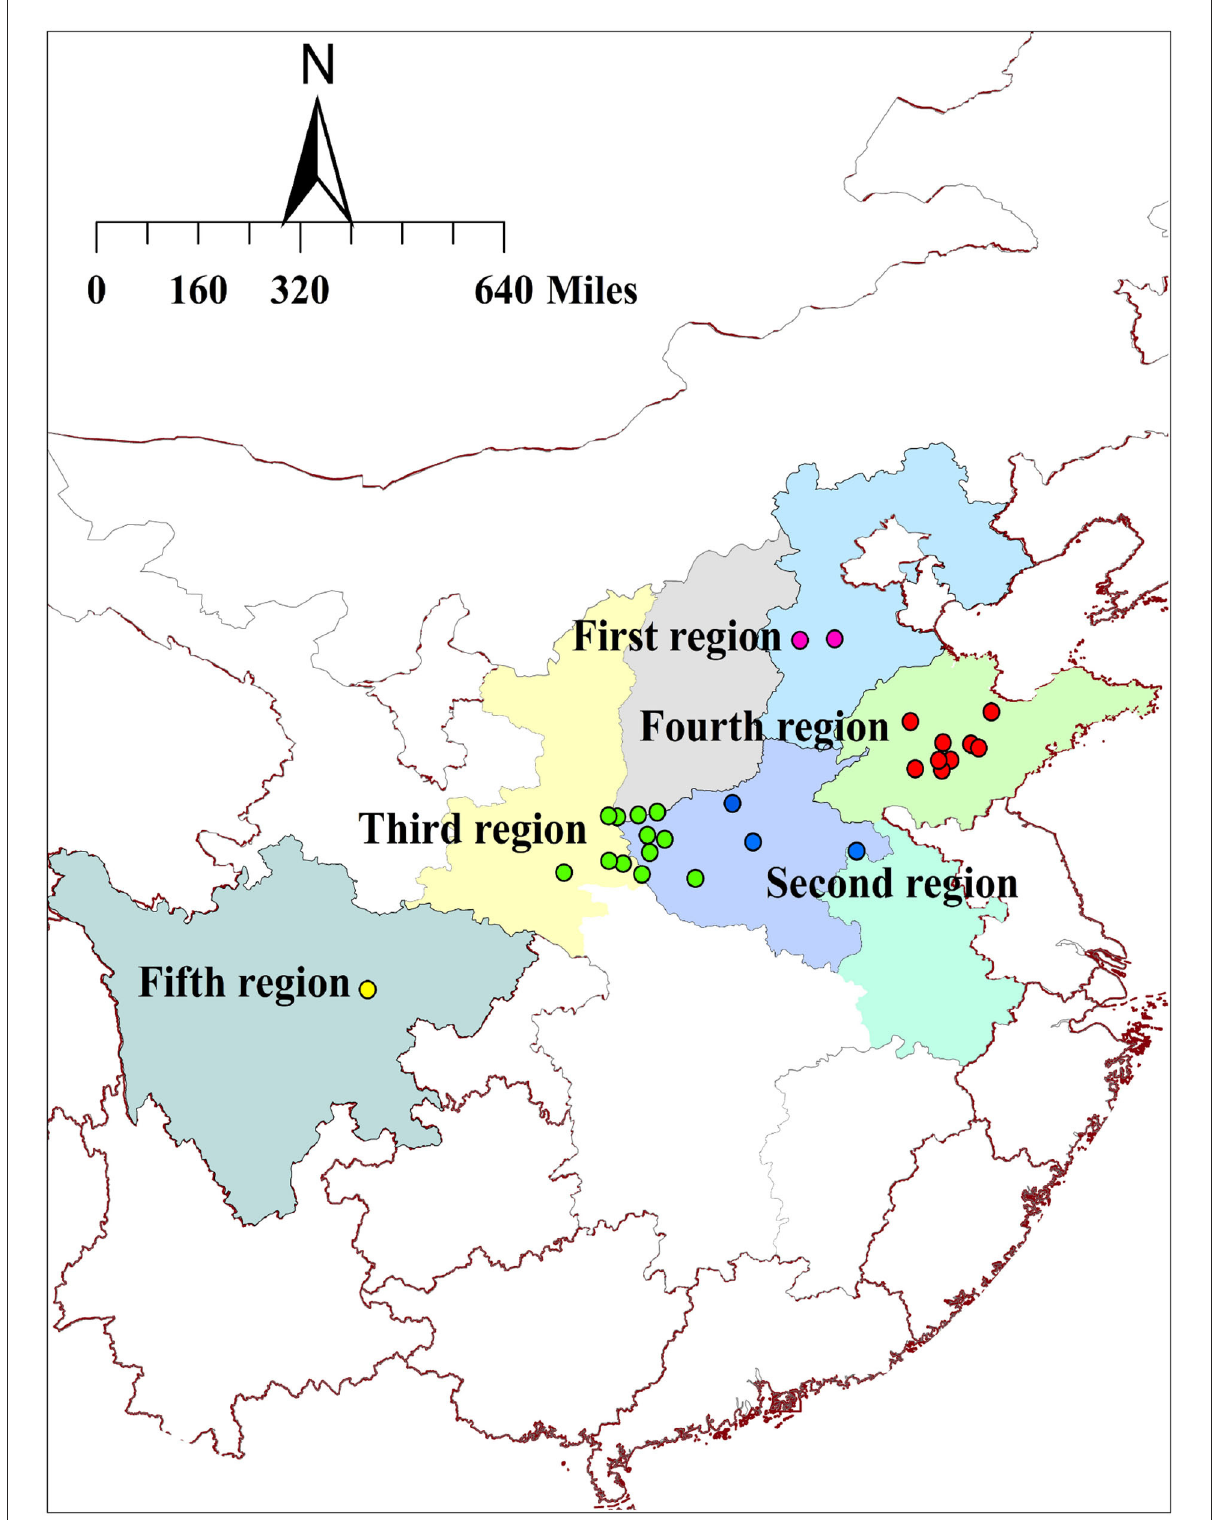
FIGURE1 The distribution of sampling sites in 7 provinces in China. (Description: This figure shows parts of China consisting of the 27 sampling sites from 7 provinces for Danshen medicines. To obtain a better quality evaluation, we artificially divided these sites into 5 regions according to different environmental